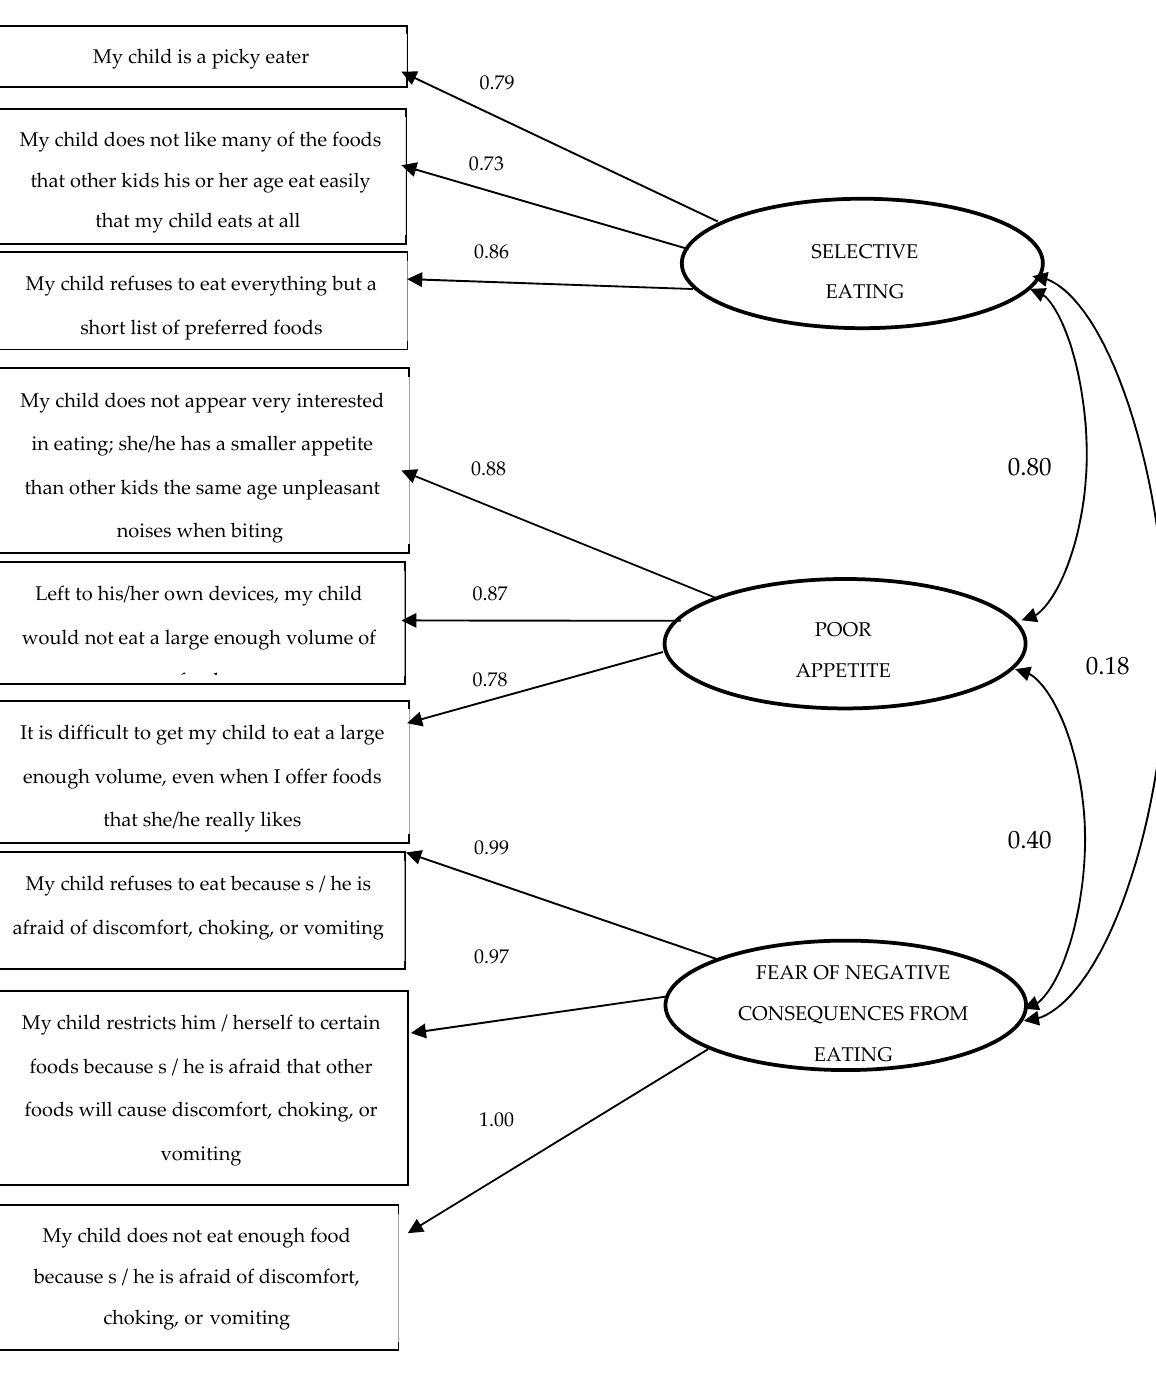
Figure 2. Confirmatory analysis showing the three factors of NIAS-PR.